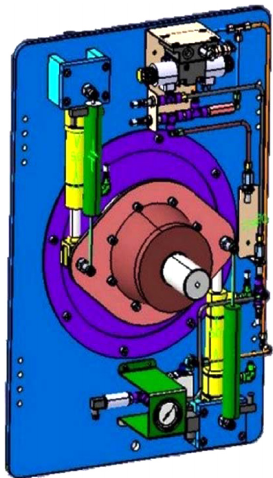
Fig. 6. System of torque generator